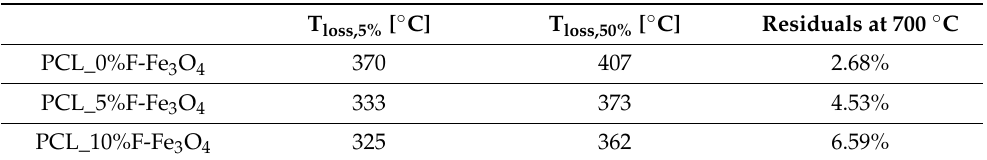
Table 1. 5%, 50% weight loss and residuals at 700 ◦ C for PCL membranes loaded with Functionalized Fe 3 O 4 nanoparticles.